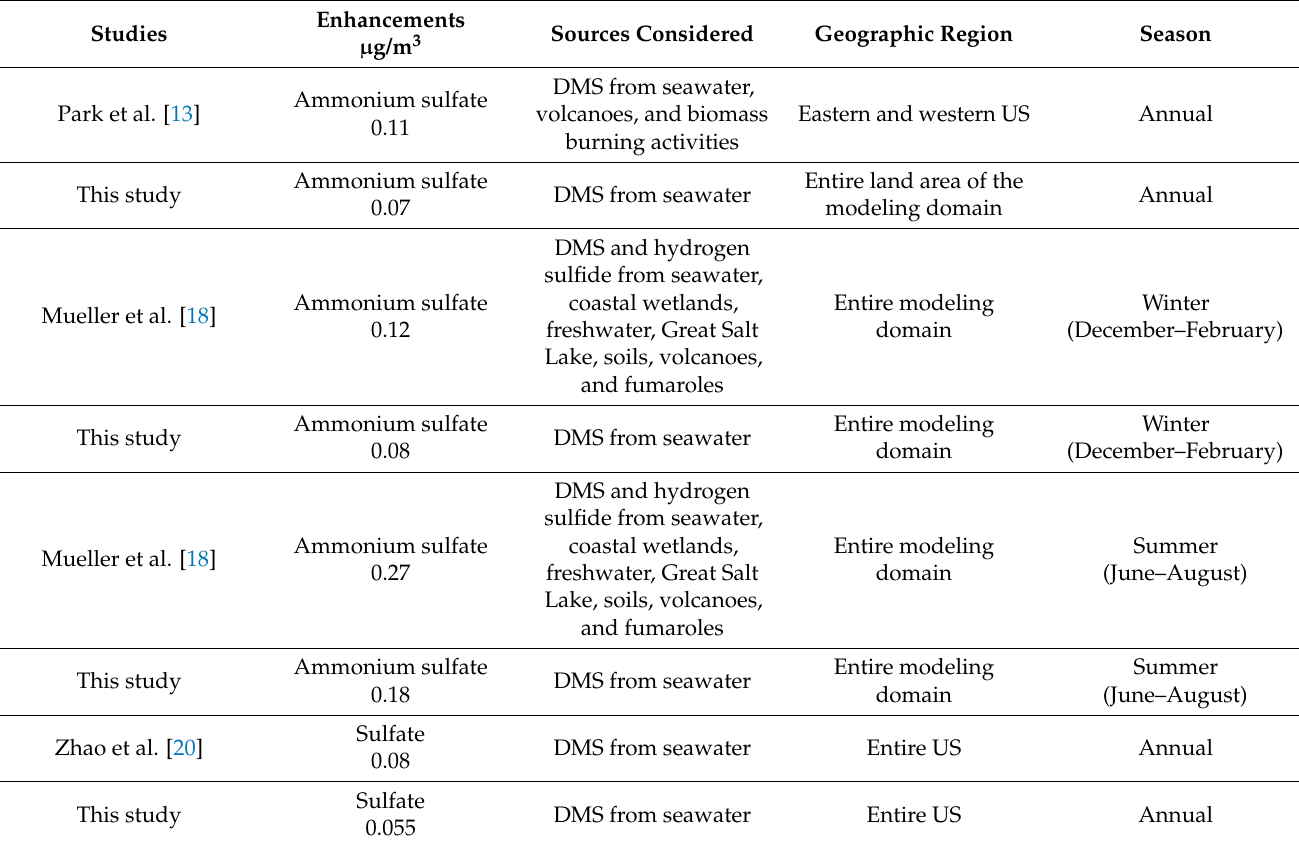
Table 2. A comparison of sulfate enhancement in different